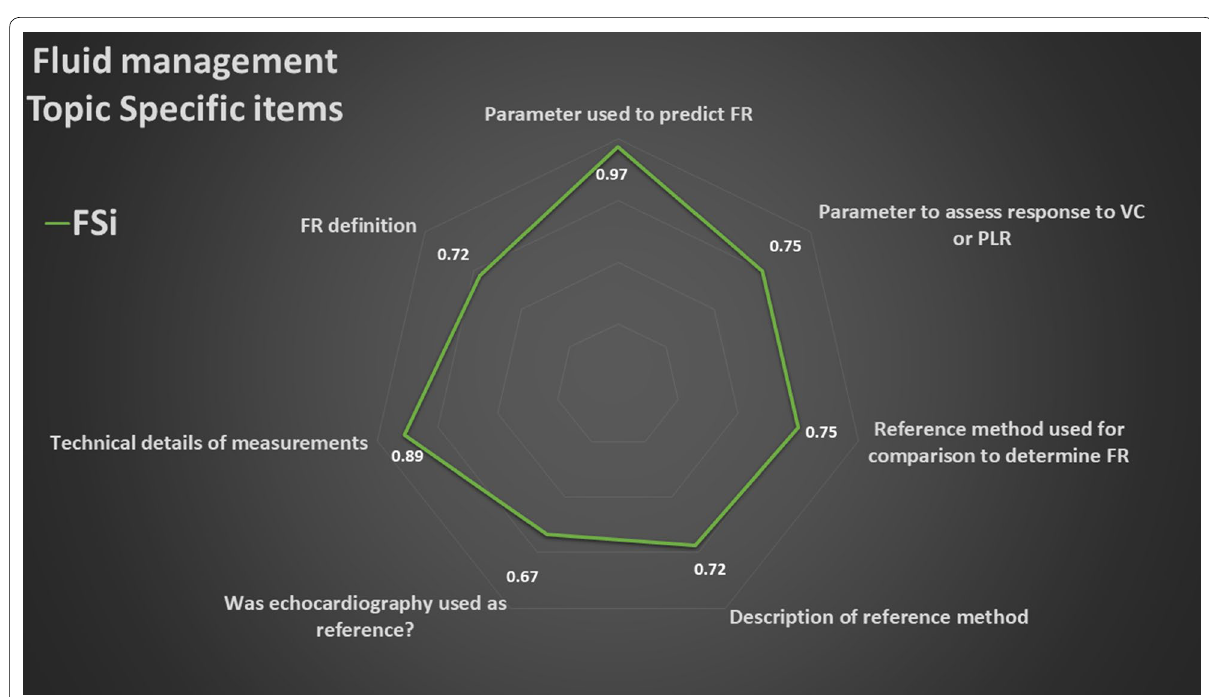
Fig. 6 Radar plot of the fraction of studies reporting an item (FSi) in the fluid management topic. FR fluid responsiveness, PLR passive leg raising, VC volume challenge. As example, an FSi score of 0.72 for FR definition means that 72% of studies on fluid management reported FR